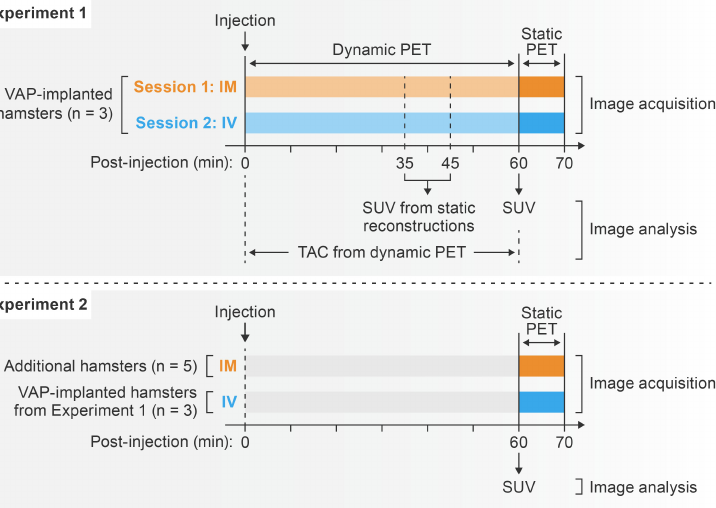
Figure 1. [ 18 F]F-FDG PET schedule. [ 18 F]F-FDG, 2-deoxy-2-[ 18 F]fluoro-D-glucose; PET, positron emission tomography; VAP, vascular access port; IM, intramuscular; IV,